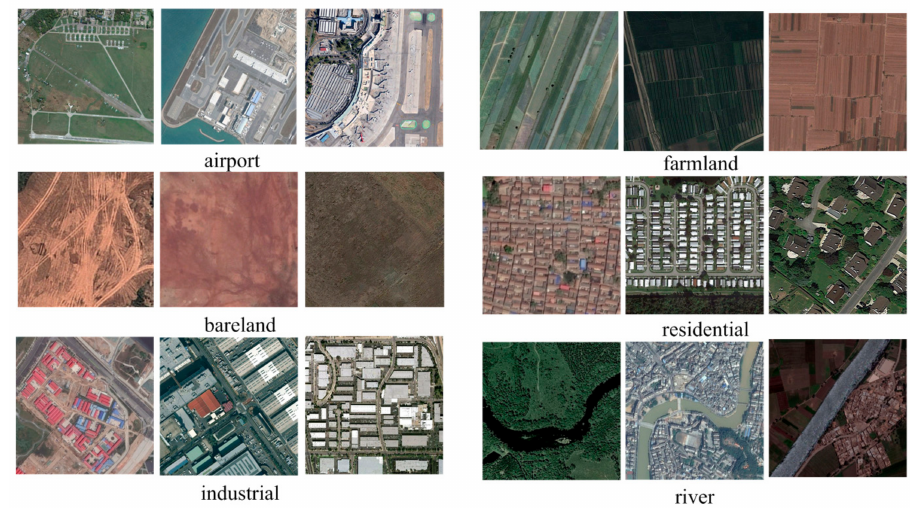
Figure 8. Sample images of the AID dataset used in the source domain.